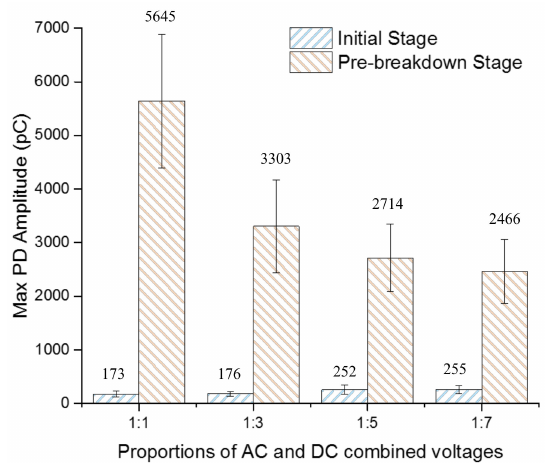
Figure 15. Relationship between max PD amplitude and AC/DC proportions.